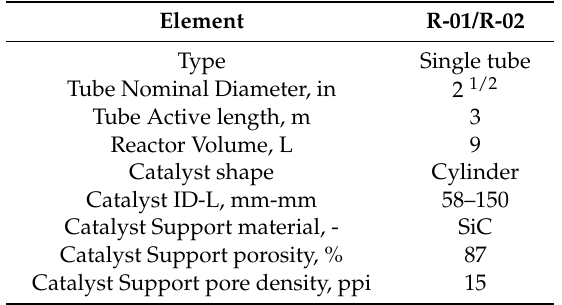
Table 1. Main characteristics of steam reforming reactors and catalyst.